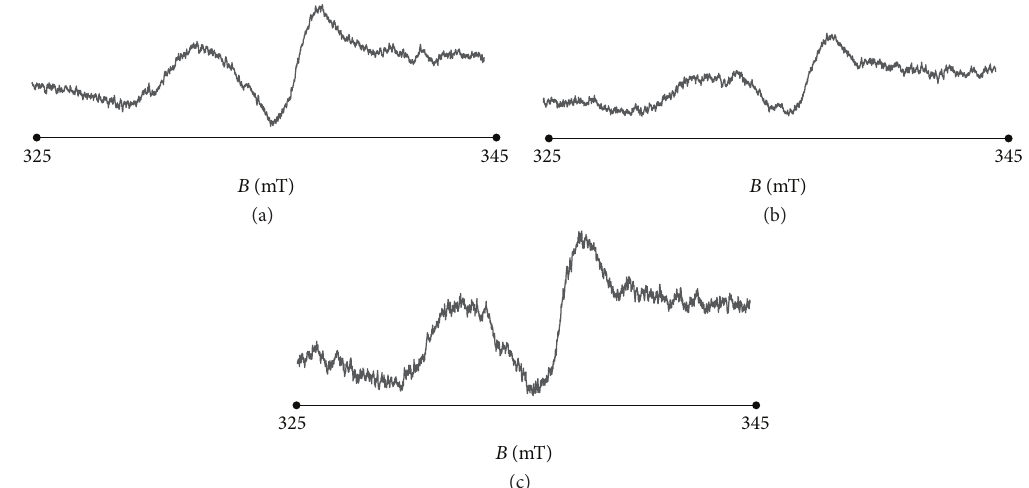
Figure 3: EPR spectra of bismuth subgallate thermally sterilized at 160 ∘ C (120 minutes), 170 ∘ C (60 minutes), and 180 ∘ C (30 minutes). 𝐵 — magnetic induction. The spectra were measured with attenuation of 15dB at room temperature.